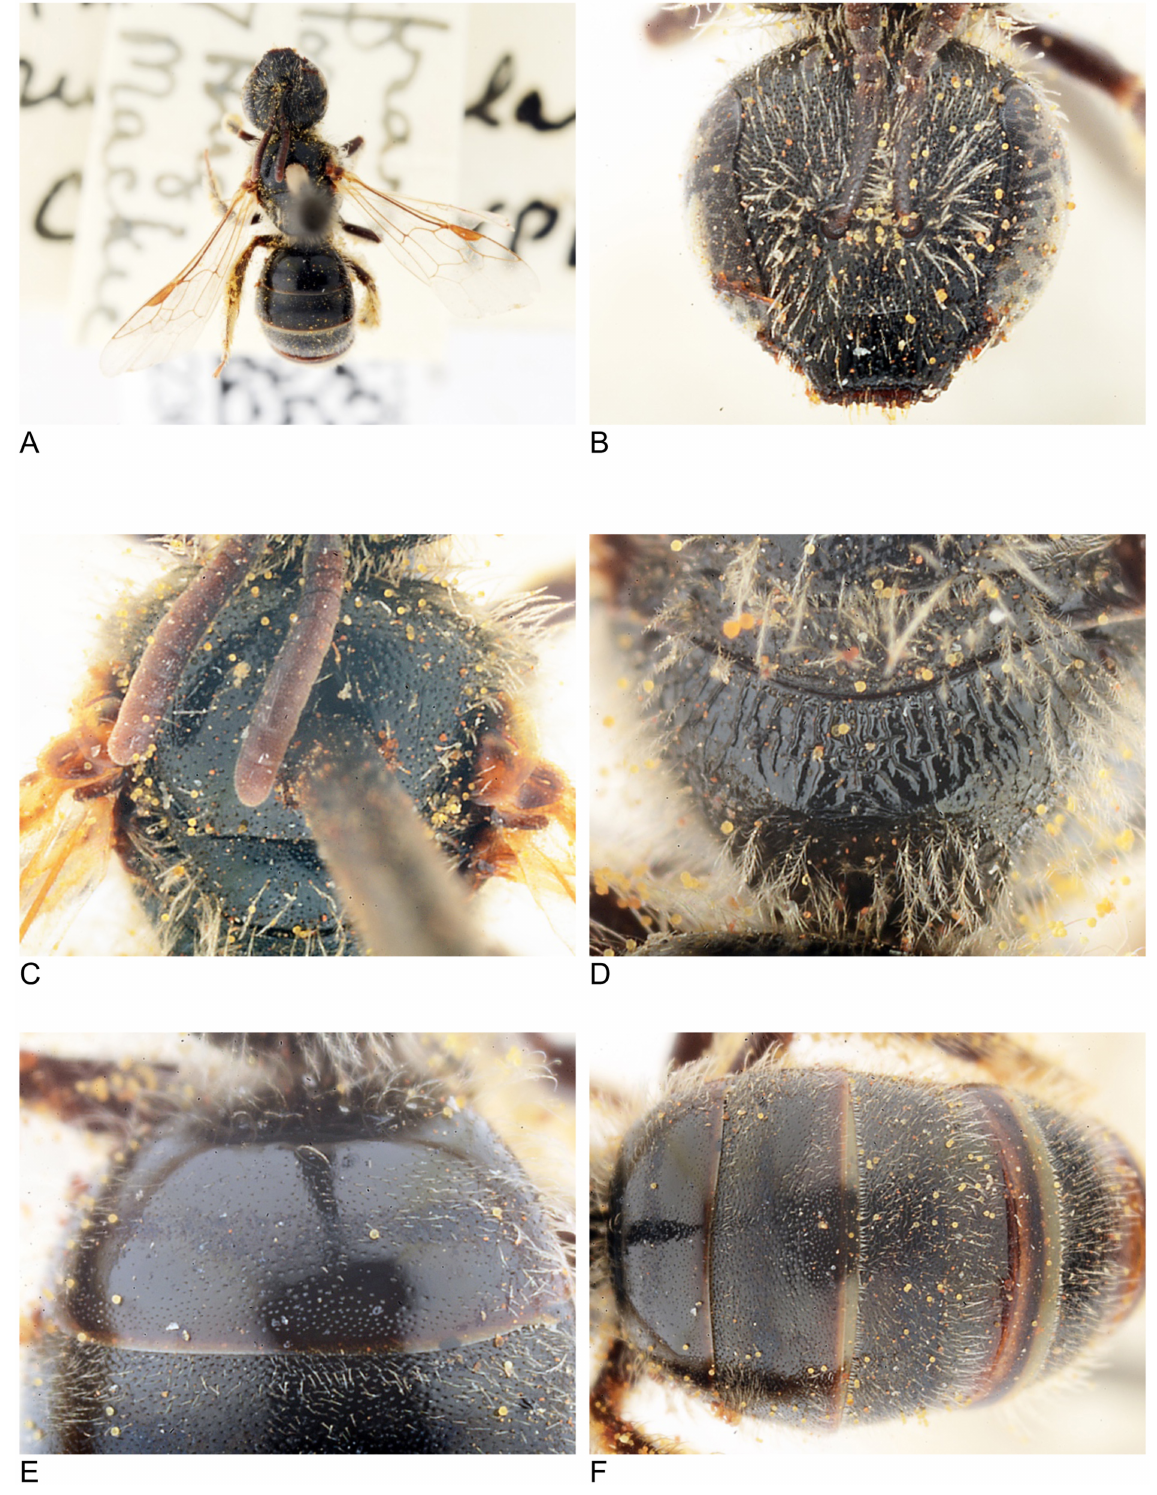
Fig. 9. Halictus rufotegularis Cockerell, 1938, holotype, ♀. A . Habitus, dorsal view. B . Head. C . Scutum. D . Propodeum. E . First tergum. F .